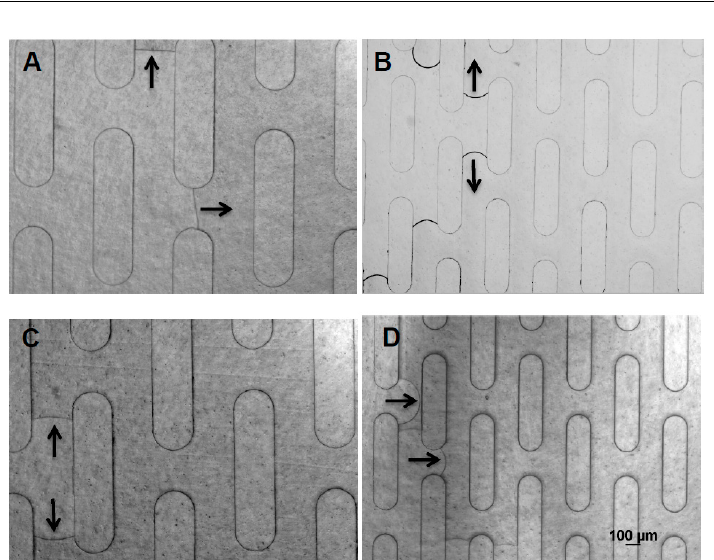
Figure 3. Representative results show the dynamic contact angles in the capillary pumps (CP). ( A ) CP1, Pluronic functionalized PDMS (Pluronic/PDMS (4 μ L/g)); ( B ) CP2, Pluronic functionalized (Pluronic/PDMS (4 µ L/g)); ( C ) CP1, Pluronic functionalized PDMS (Pluronic/PDMS (2 µ L/g)); ( D ) CP2, Pluronic functionalized PDMS (Pluronic/PDMS (2 µ L/g)). The black arrows indicated the flow direction in the capillary